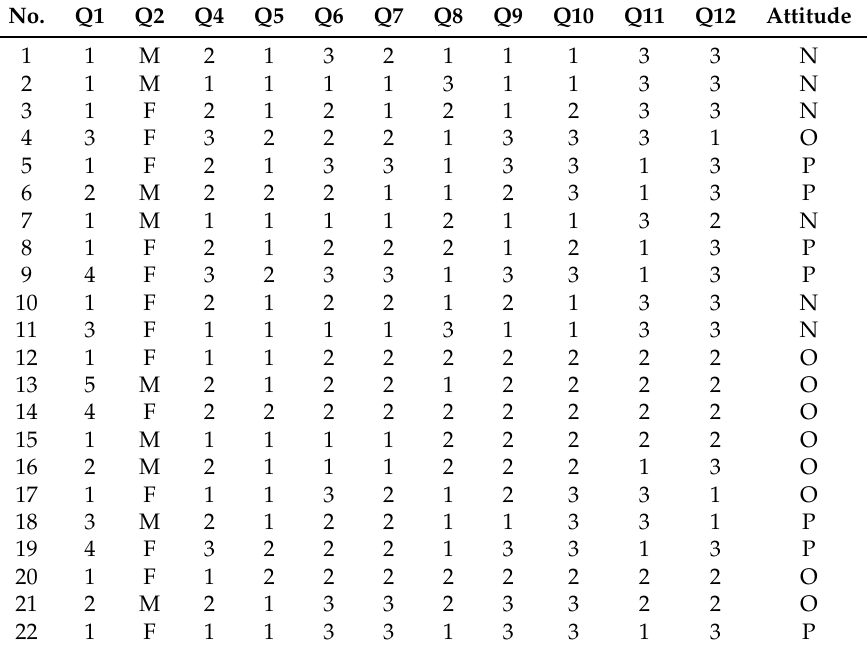
Table A2. Questionnaires about English learning attitudes for